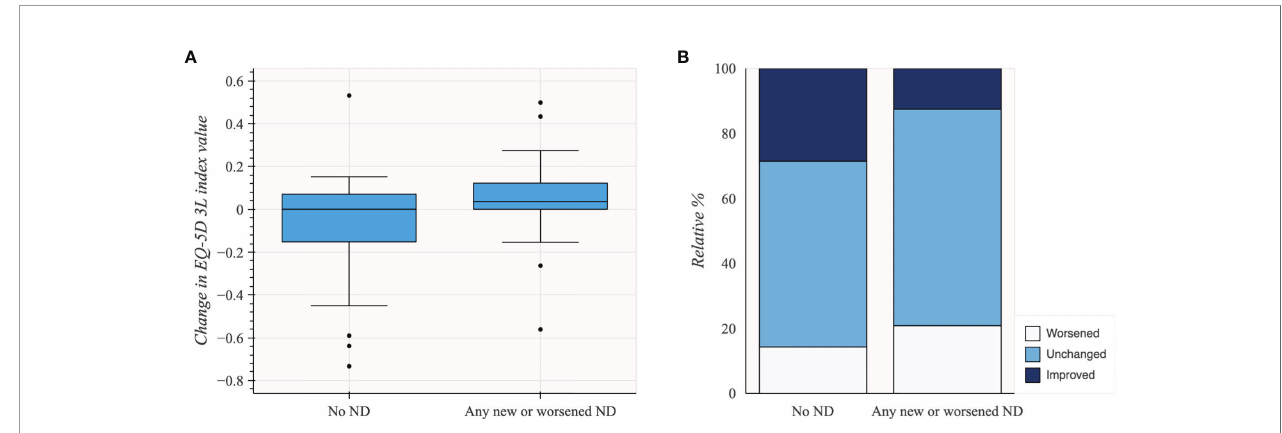
FIGURE 5 | Change in EQ-5D 3L index value in patients grouped by the presence of neurological de fi cit (ND) at follow-up ( N = 45). (A) Box plot illustrating distribution of change in EQ-5D 3L index values. (B) Stacked bar plot illustrating change using MCID